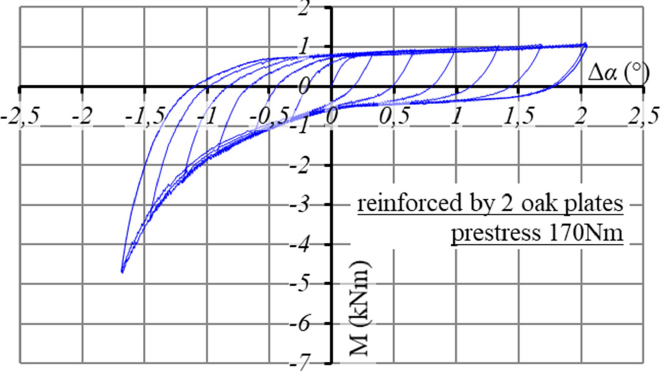
Figure 11. Hysteresis loops of a joint retrofitted with oak plates.